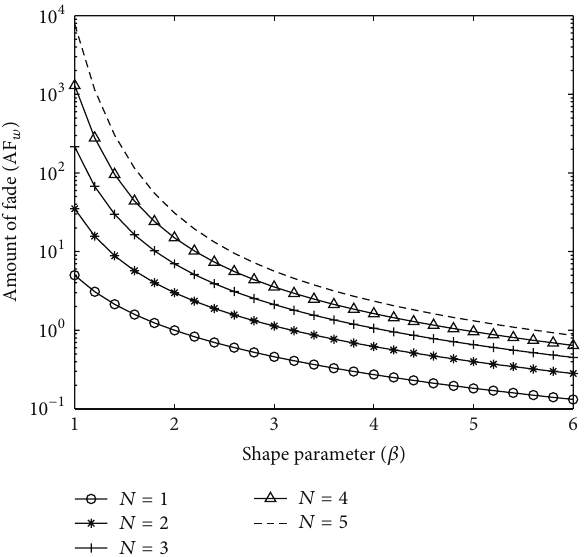
Figure 4: Amount of fade for 𝑁 -Weibull compound